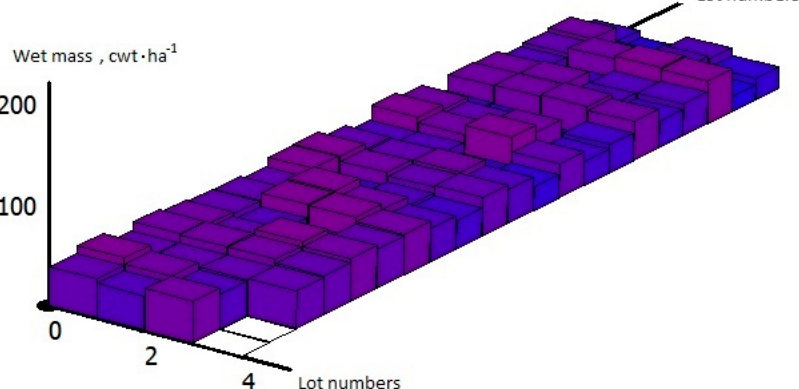
Figure 12. Distribution of the estimates of the wet weight of spring wheat sowing by elementary plots of the field.